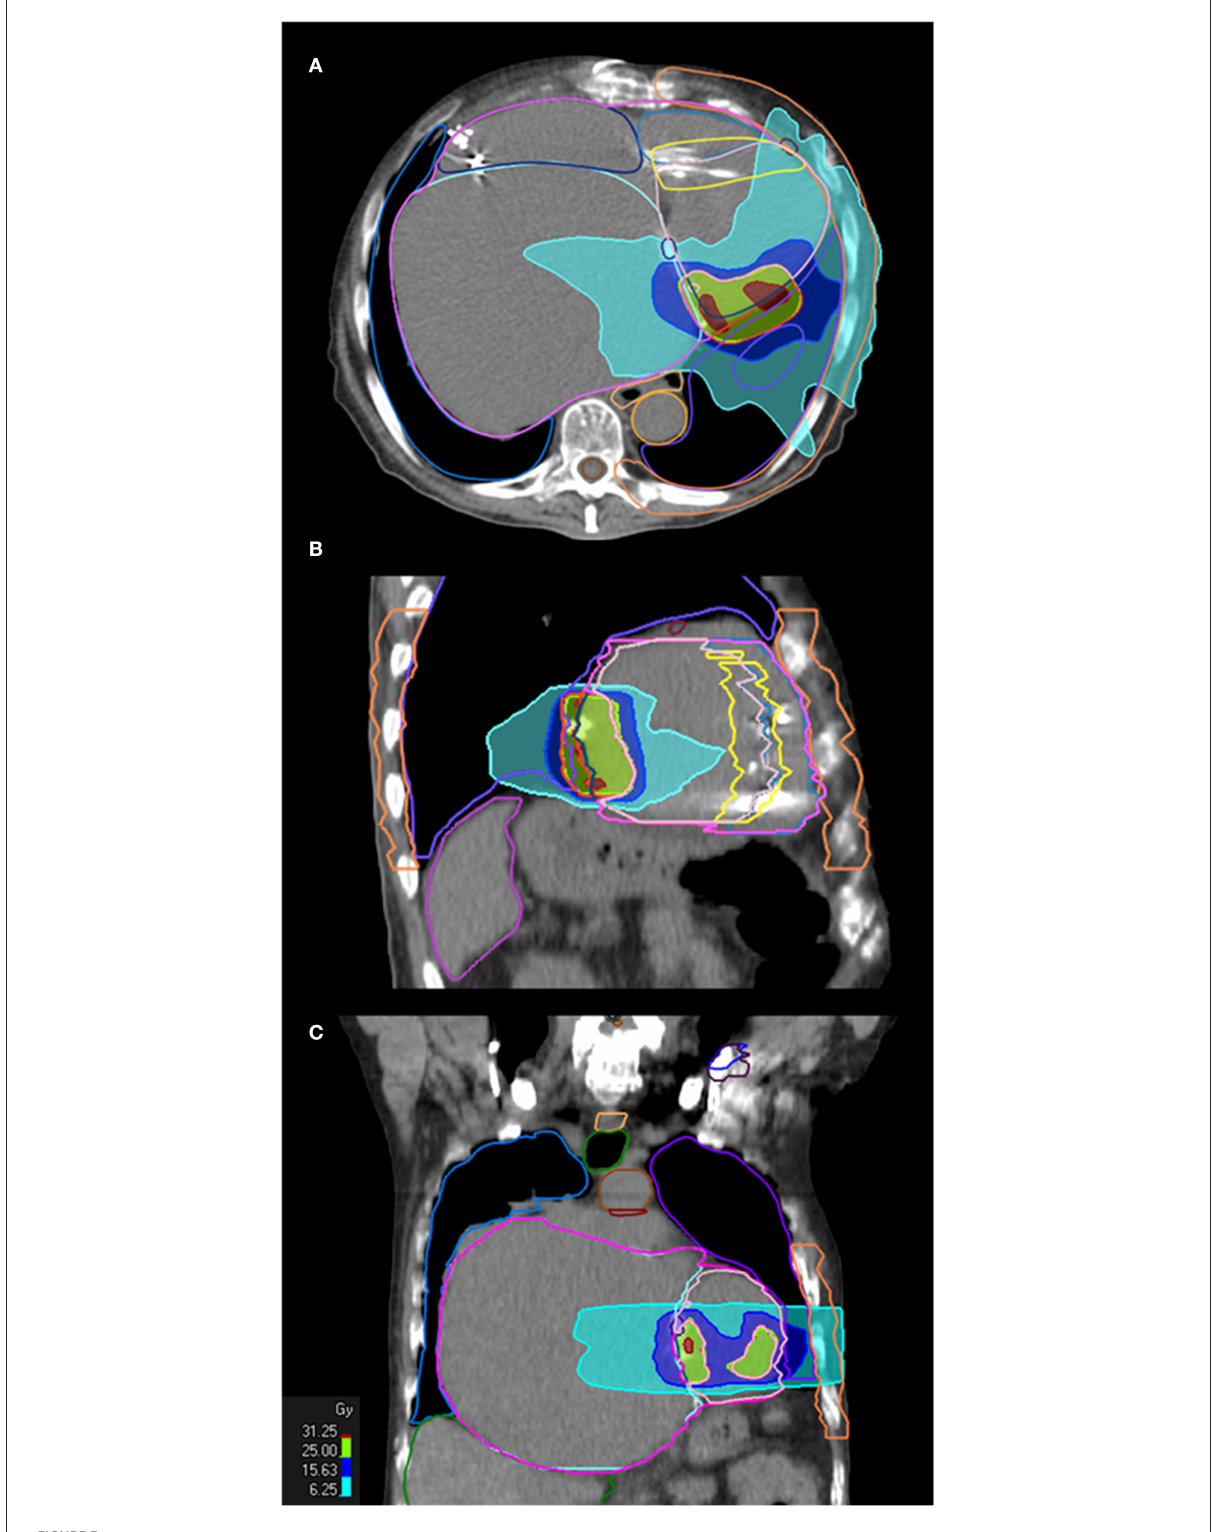
FIGURE3 STAR treatment plan. Treatment plan in axial (A) , sagittal (B) , and coronal (C) orientation are shown, with dose volume histogram (25Gy is prescribed on 80%